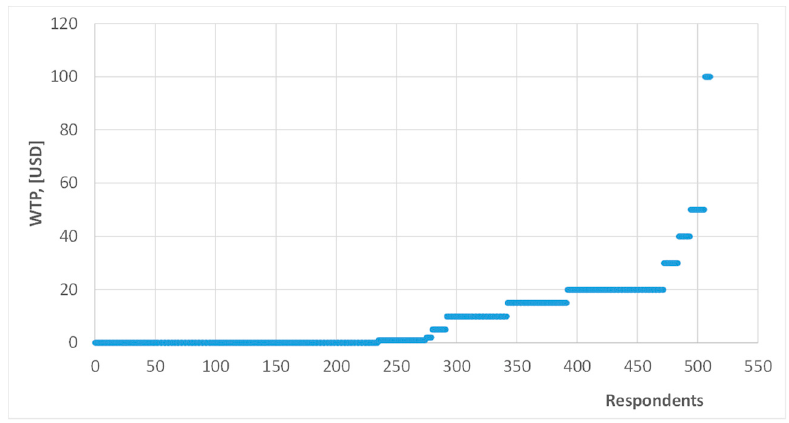
Figure 5. Distribution of the willingness to pay (WTP) in the present study.